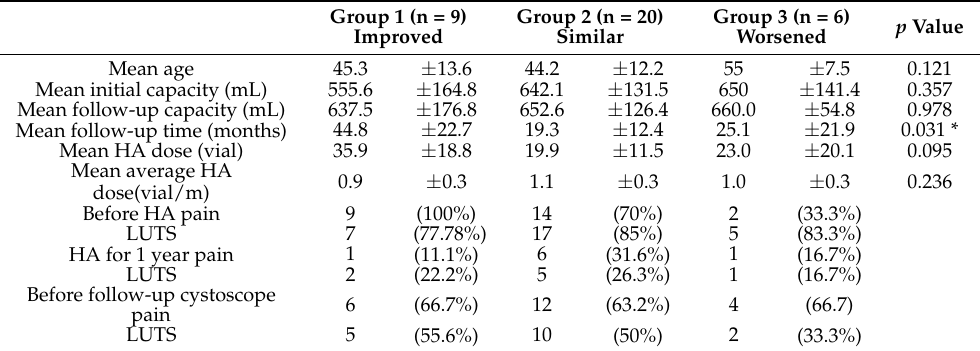
Table 3. The data of the three groups with different glomerulation grade changes revealed by cystoscopy after intravesical hyaluronic acid instillation therapy.